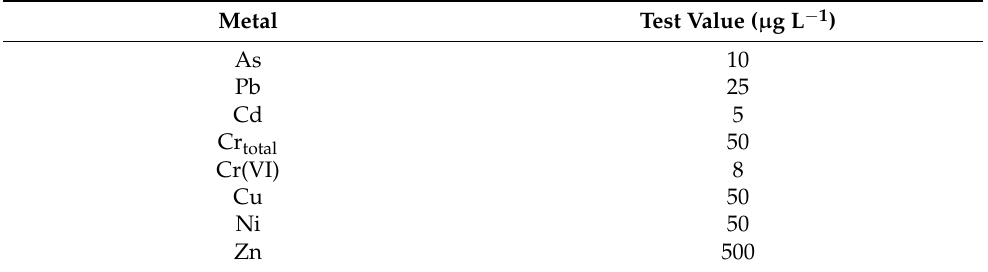
Table 5. Test values for assessing the soil–groundwater impact pathway (in µ